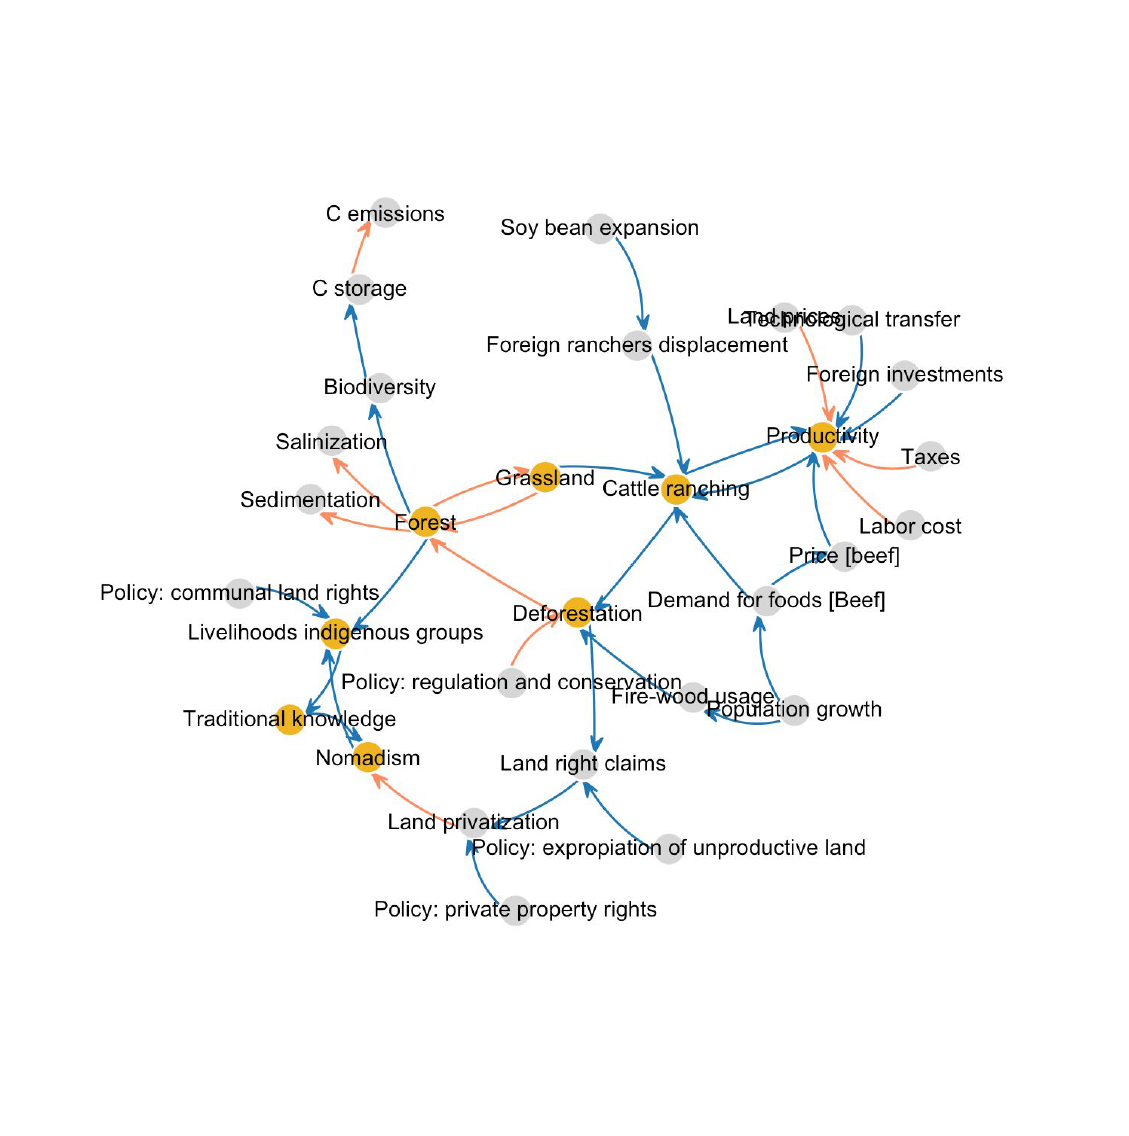
Figure A1.2. CLD cattle ranching expansion and deforestation in Paraguayan ​​